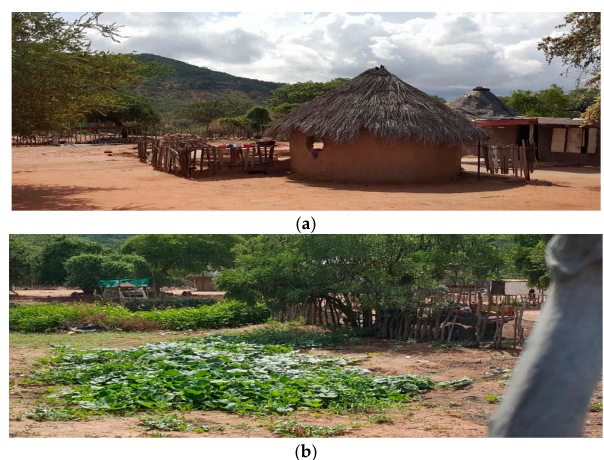
Figure 2. Housing and agriculture activities in Gwakwani village. ( a ) Cross section of Gwakwani village; ( b ) Cross section of agricultural farm.